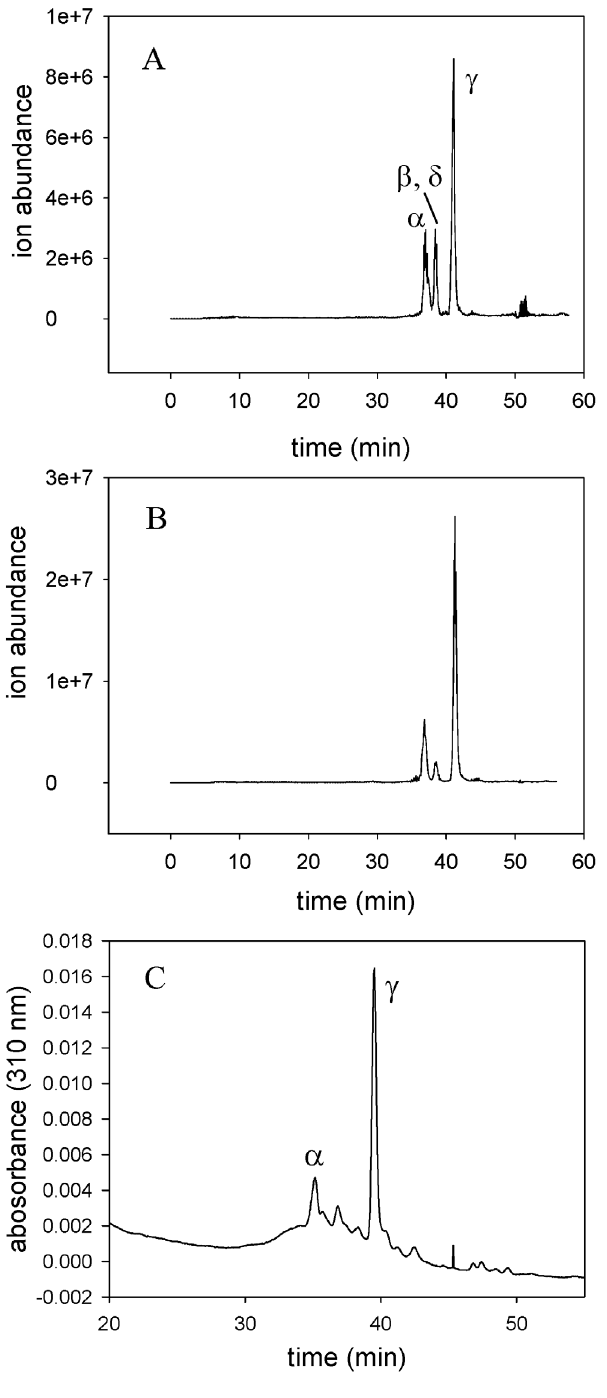
Figure 8. Analysis of products from reaction of the BBPLo complex with the NADP + - ferredoxin reductase-ferredoxin system. After a four hour reaction period, the reaction was extracted and methyl esters were synthesized as described in the Materials and Methods section. The products were separated by reversed phase HPLC and detected by absorbance at 310 nm followed by nanospray mass spectrometry. (a) Selected ion trace in the mass range from m/z 609– 614 showing the isomers of biliverdin methyl ester as labeled. These are the products after 1 hr of incubation in the presence of catalase, when substantial amounts of heme are still present. (b) The same mass range as (a) after 4 hr reaction. At this point, little heme remains. (c) Absorbance trace of reaction (b) monitored at 310 nm.